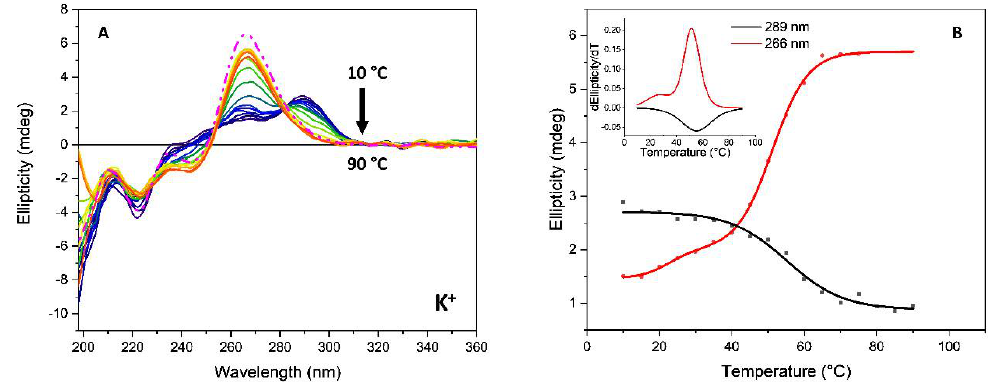
Figure 9. ( A ) Influence of temperature on the SRCD of G3T3 (13.5 μM) with 2.2 eq. of Rhau25 peptide in 10 mM Tris-HCl buffer, pH 7.4, 70 mM potassium ions. The temperature range was from 10 °C to 90 °C every 5 °C. The dashed line represents the oligonucleotide cooled to 20 °C after heating to 90 °C. The arrows represent the direction of the spectral change as the temperature is increased; ( B ) Plot of SRCD intensity versus temperature at 266 nm (red) and 289 nm (black). Insert: Comparison of the corresponding first derivative of the SRCD at 266 nm and 289 nm.